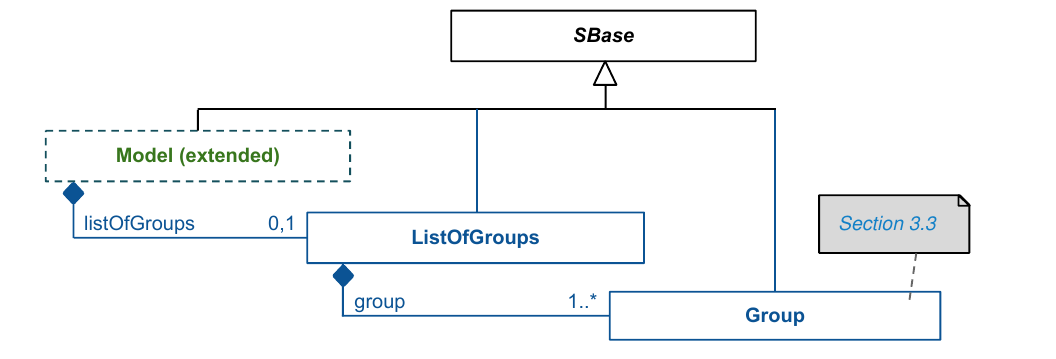
Figure 2: The extensions of the Model class. Group is defined in Section 3.3 on page 5. In other respects, Model remains defined as in the SBML Level 3 Version 1 Core